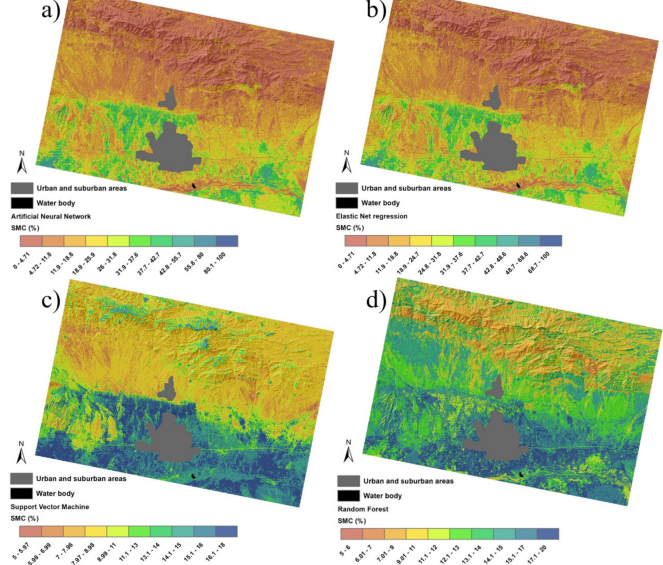
Figure 5. Estimated SMC (%) from Landsat 8 OLI and TIRS data (30 m) using Training datasets for the study area at 06:43 AM UTC, on 7 March 2017. ( a ) Artificial Neural Network ( b ), Elastic Net regression ( c ), Support Vector Machine, and ( d ) Random Forest. SMC maps overlaid on hillshade using 30 percent